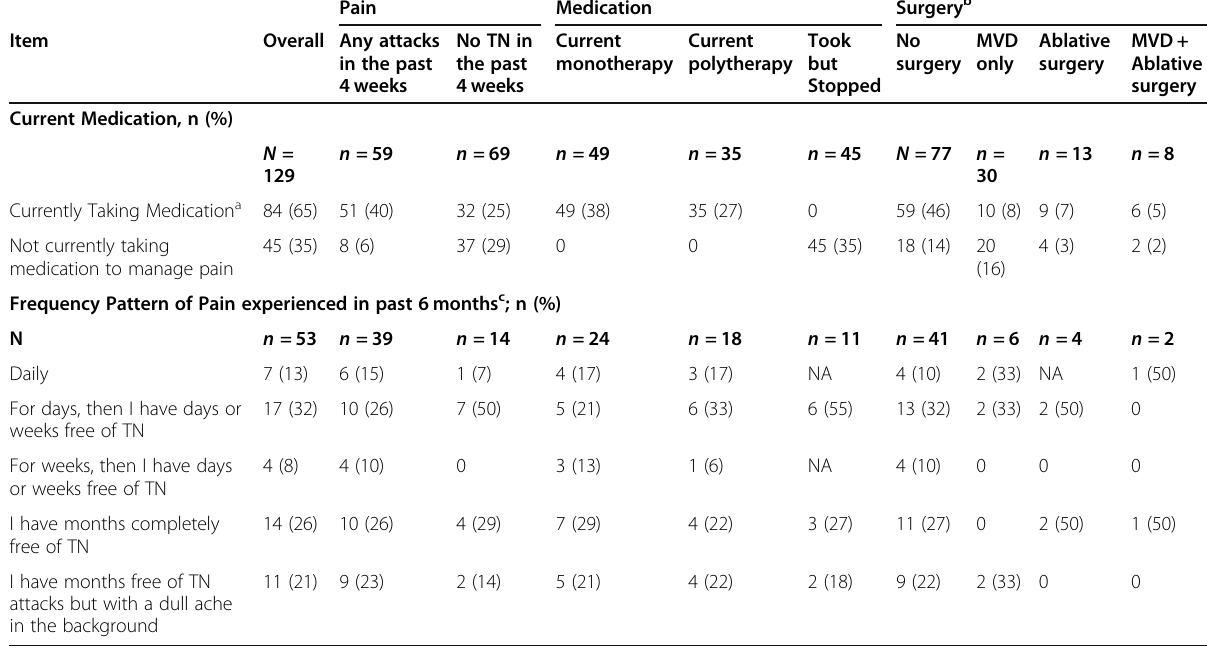
Table 6 Pain Control by Pain, Medication and Surgical History